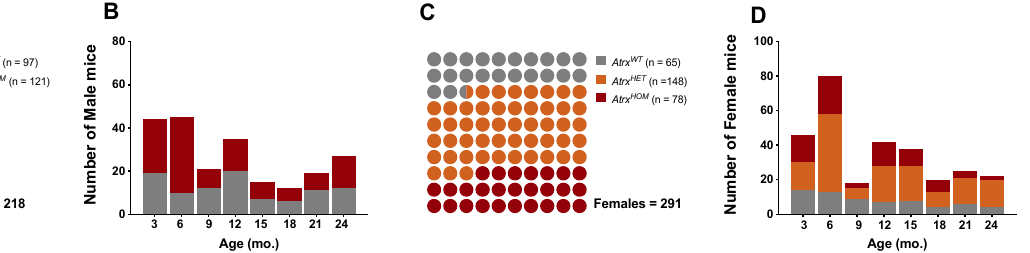
Figure 1. Study population . The proportion of genotypes between male ( A , B ) and female mice ( C , D ), with the respective distribution by the eight age groups. Grey means Atrx WT , red means Atrx HOM , and orange means Atrx HET . Mice ages were calculated by the time of